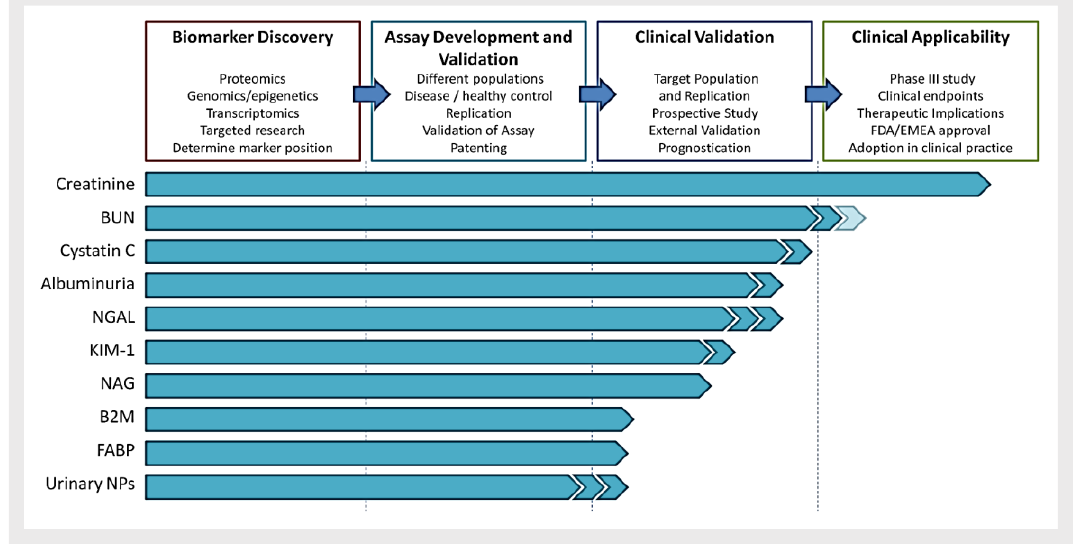
Figure 1. Renal biomarker development. Approach to renal biomarker discovery and clinical applicability. B2M, b-2-microglobulin; BUN, blood urea nitrogen; FABP, fatty acid-binding protein (types L and H); KIM-1, kidney injury molecule 1; NAG, N -acetyl-β- D -glucosaminidase; NGAL, neutrophil gelatinase-associated lipocalin; NP, natriuretic peptide. Reprinted from [10].